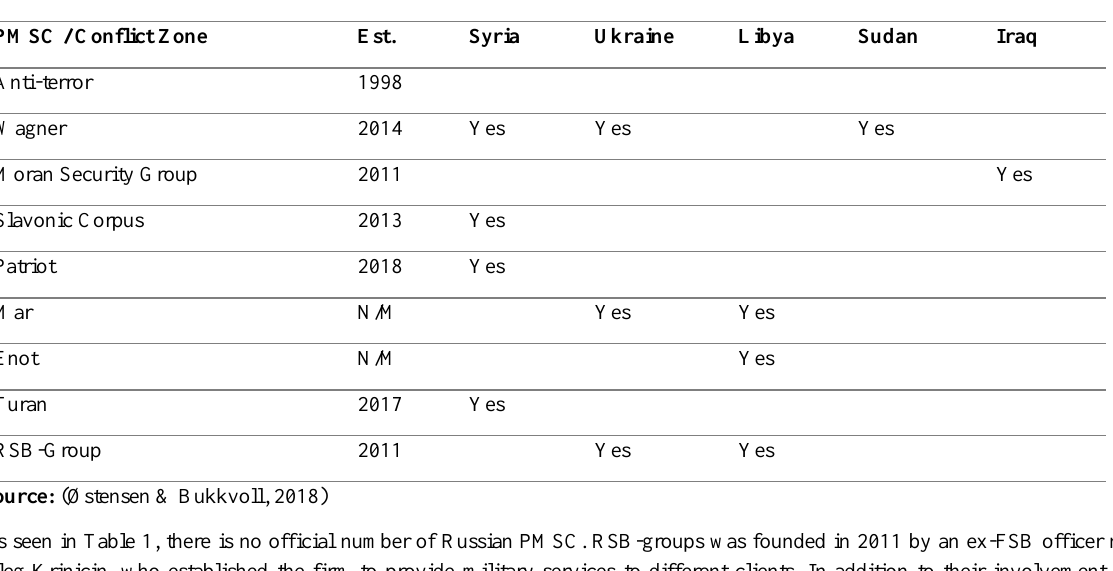
Table 1: Russian PMSC in conflict